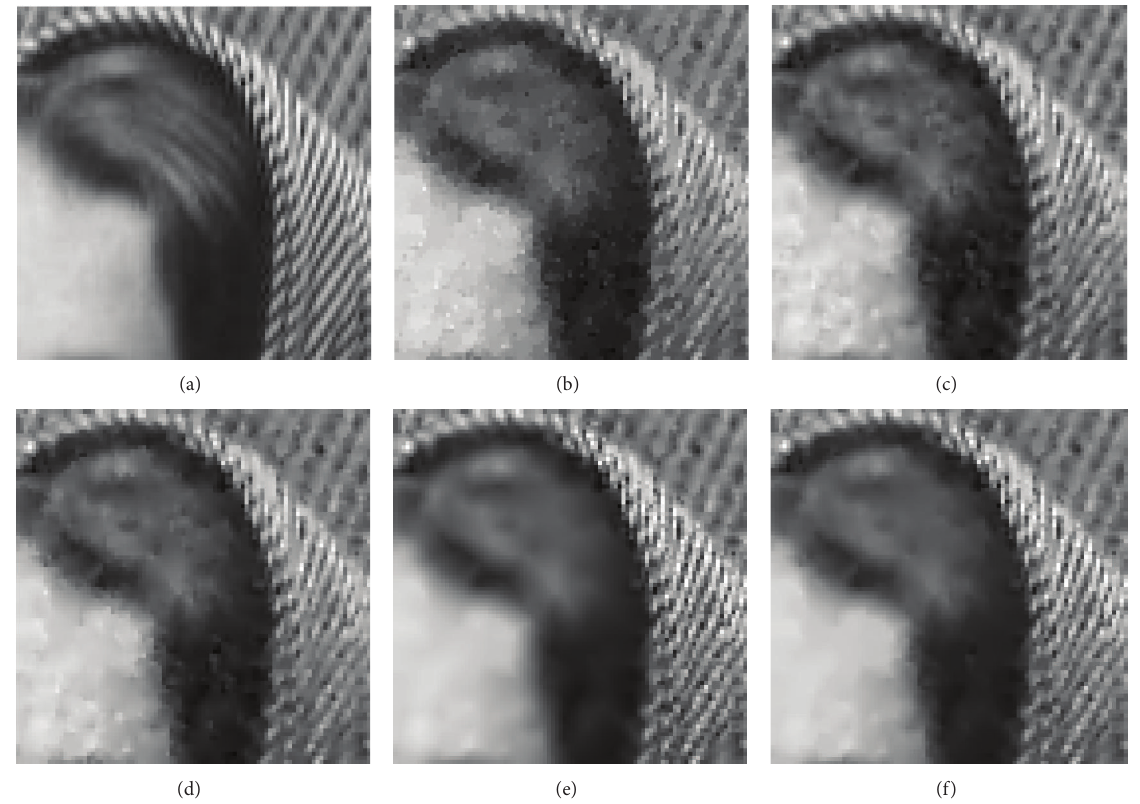
Figure 8: Zoomed-in local results corresponding to Figures 6(b)–6(f): (a) the original image, results of (b) the ROF model, (c) the LLT model, (d) the hybrid model, (e) our Model 1, and (f) our Model 2.